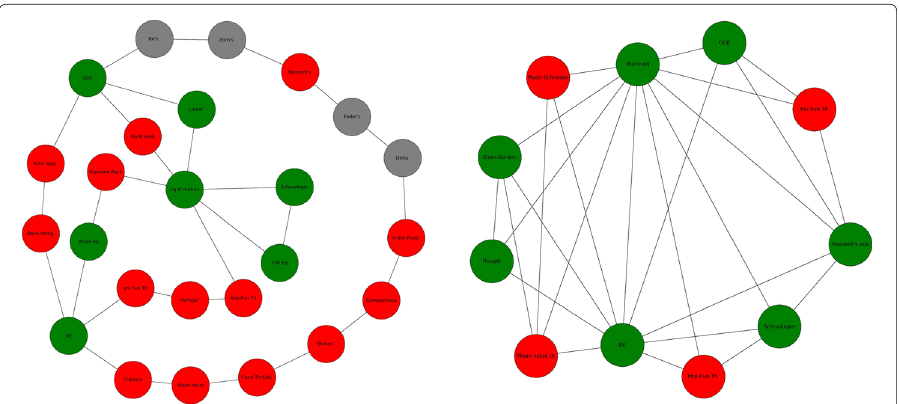
Fig. 6 Example of a H 1 cycle, a hole bounded by edges (left) and a H 2 cycle, hole bounded by triangles (right). Nodes color: red for theorems, grey for lemmas and green for